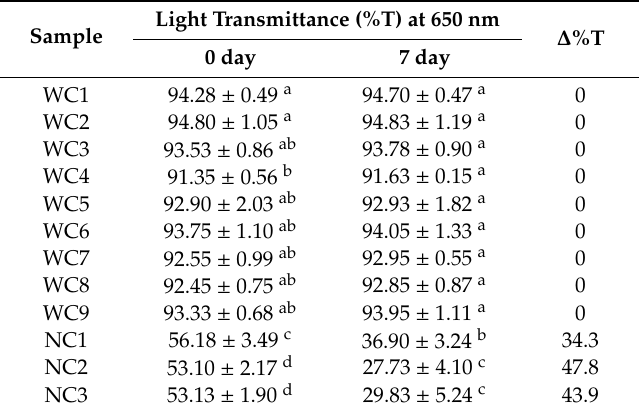
Table 3. Light transmittance at 650 nm of 2% starch pastes from WC1–WC9 and NC1–NC3 before and after storage at 4 °C for 7 days.